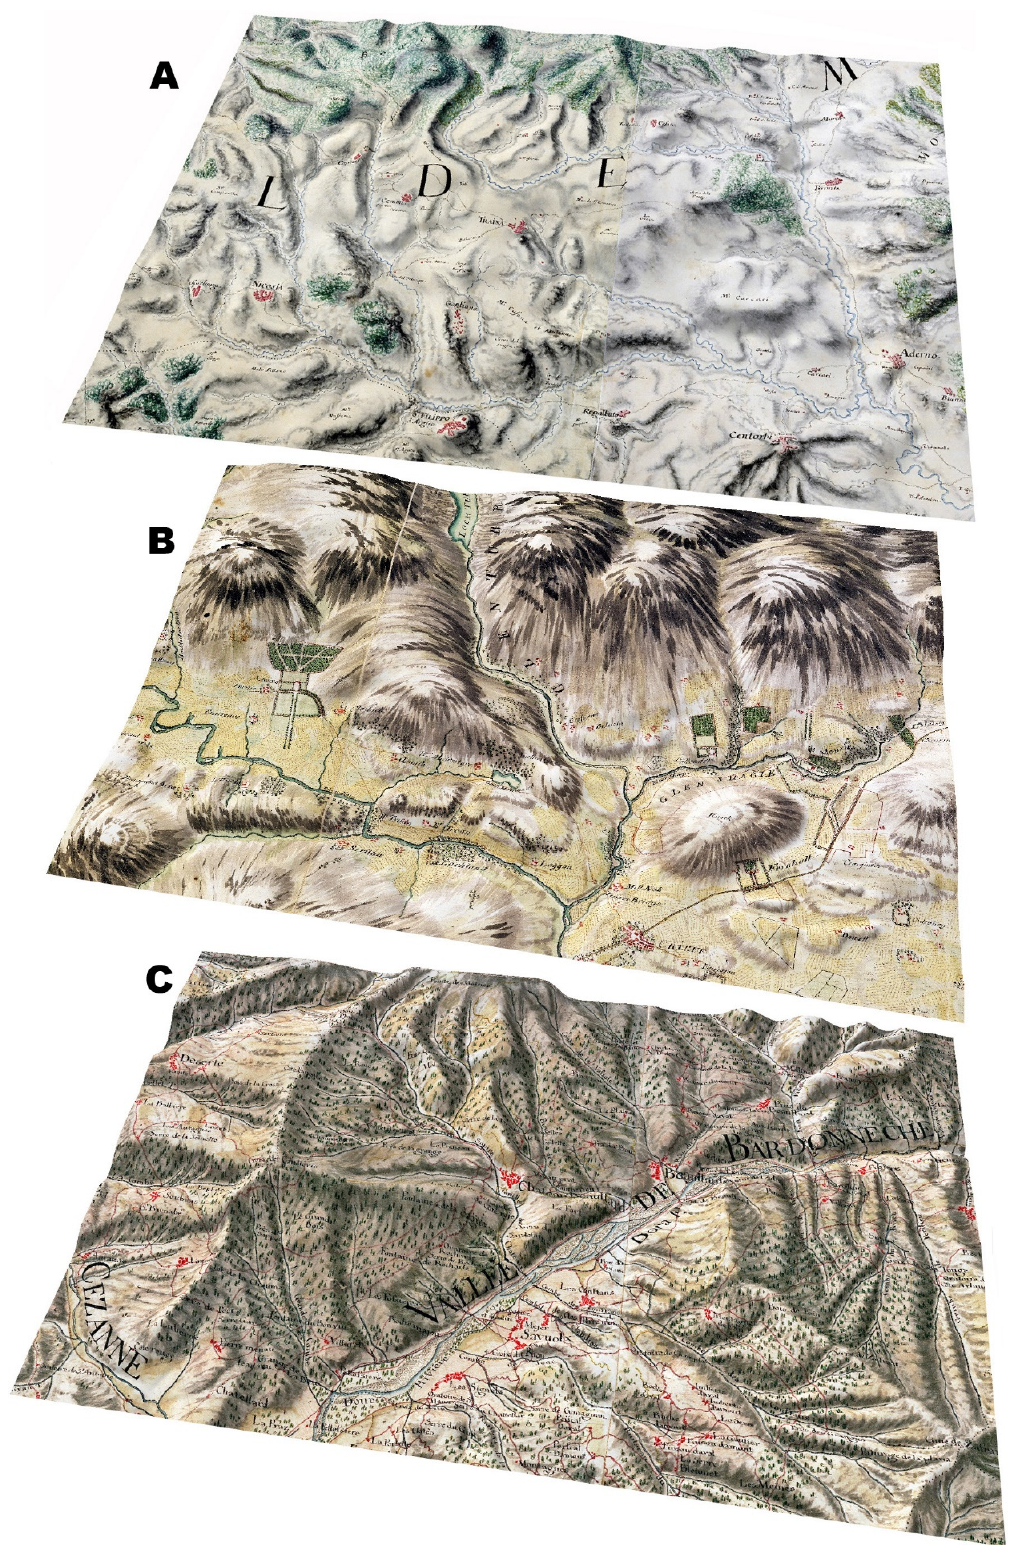
Figure 9. Final bird’s-eye view with the following values adopted: vertical scaling = 4, contrast 40%; illumination: azimuth 315° = NW, altitude 45°, slightly inclined towards the viewer (to the right) by approximately 20°; ( A ): from a detail of the Sicily map; ( B ): from a detail of the Scotland map; ( C ): from a detail of the Susa map.